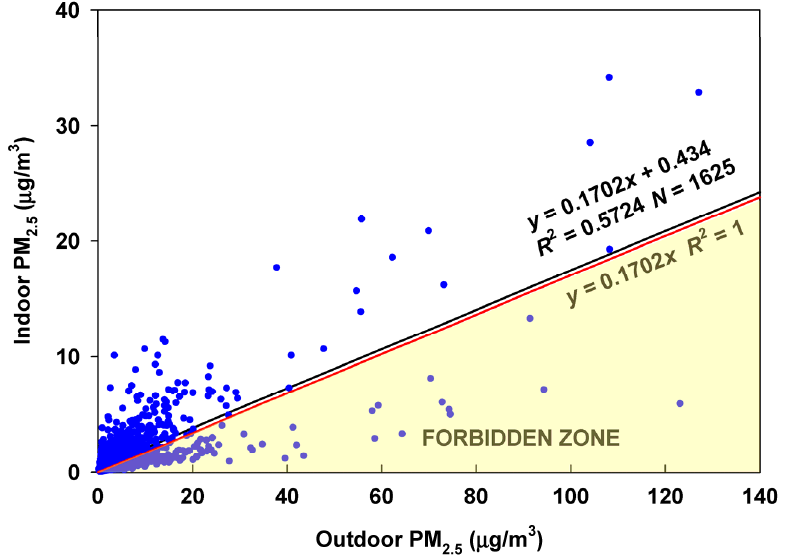
Figure 10. Regression of Alexander Avenue indoor PM 2.5 on Alexander Avenue outdoor PM 2.5 .